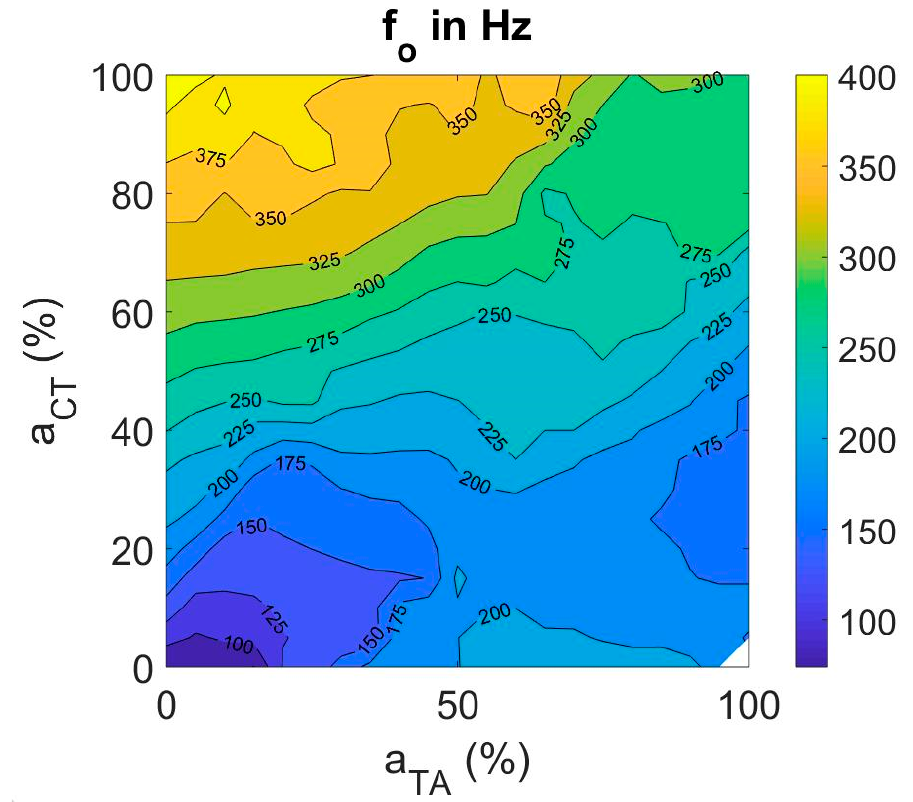
Figure 5. Muscle activation plot with fundamental frequency ( f o ) as contour feature.